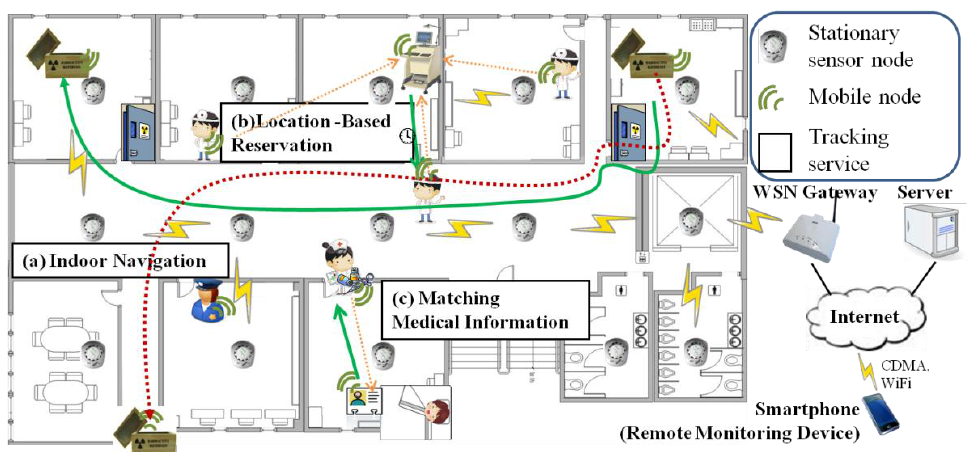
Figure 1. Mobile asset tracking services in a